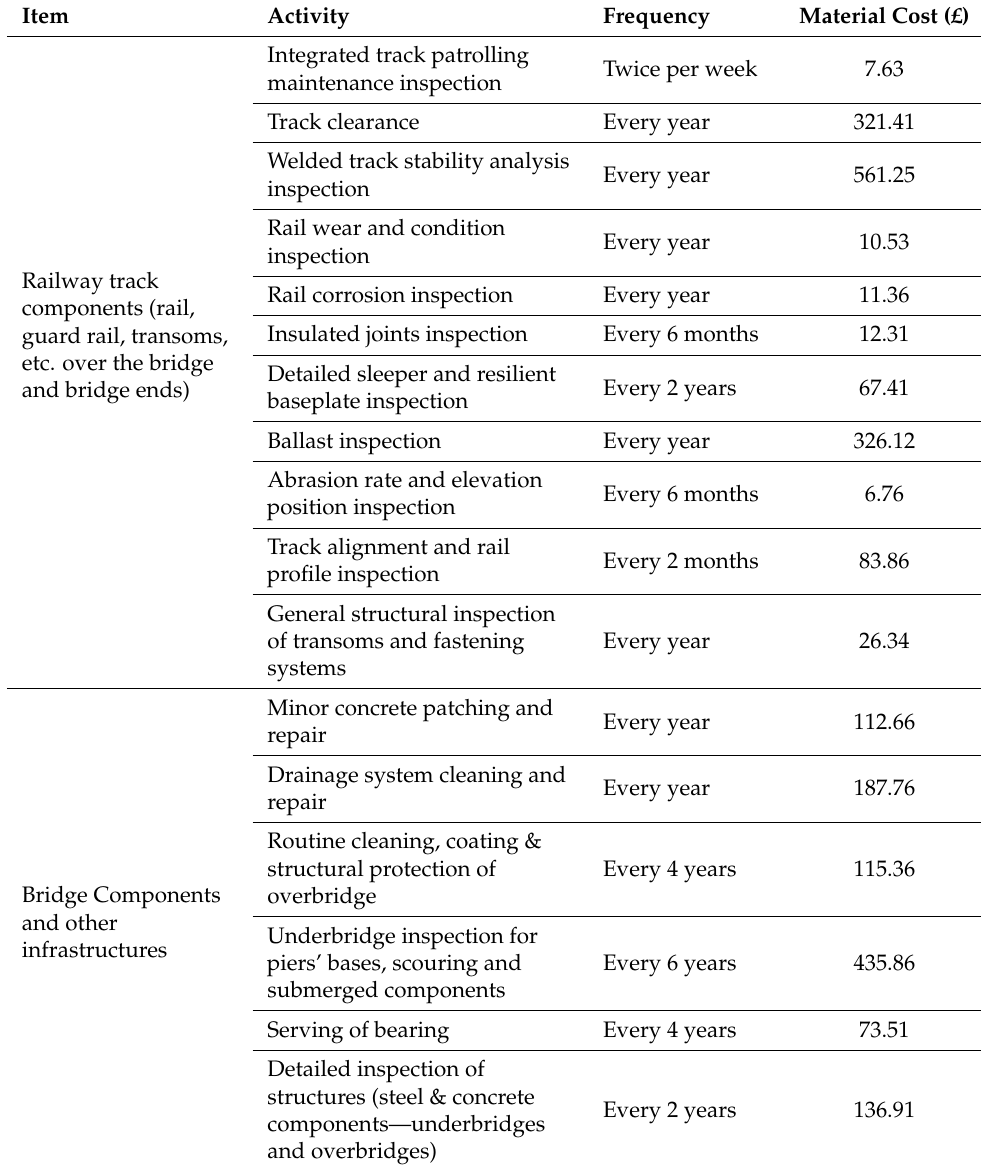
Table 4. Heavy rail preventive maintenance and estimated costs in the Minnamurra Railway Bridge. Note that this is an estimation and can be adjusted to suit any future change in activities, frequencies, or